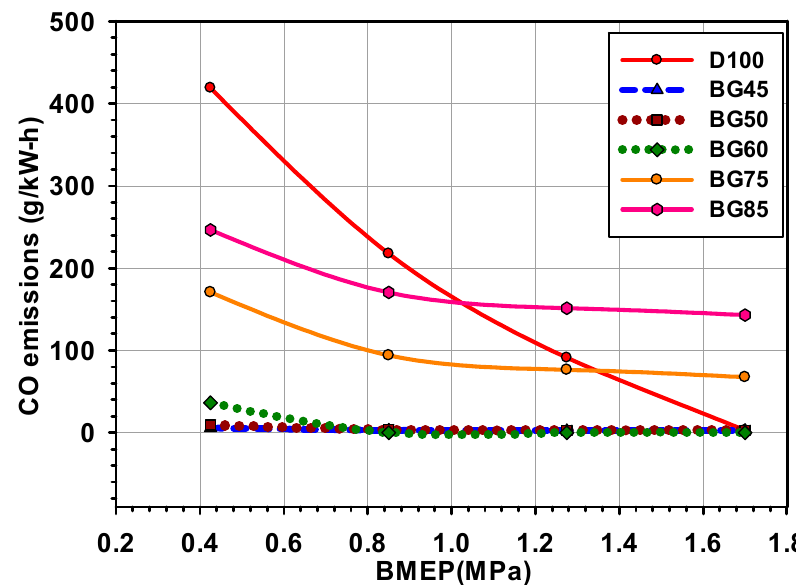
Figure 16. Variations of CO emissions with load.